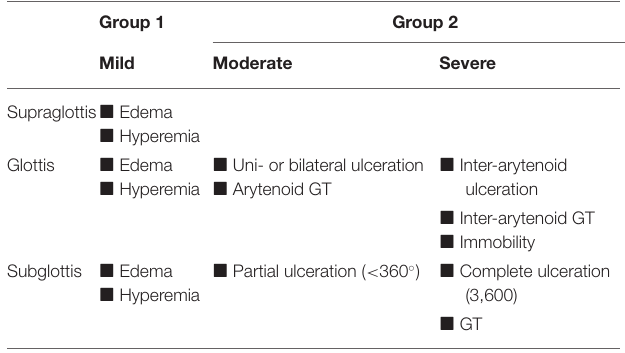
TABLE 1 | Classification of acute laryngeal Injuries (CALI) as mild, moderate, or severe, according to anatomical location and type of injury. Group 1